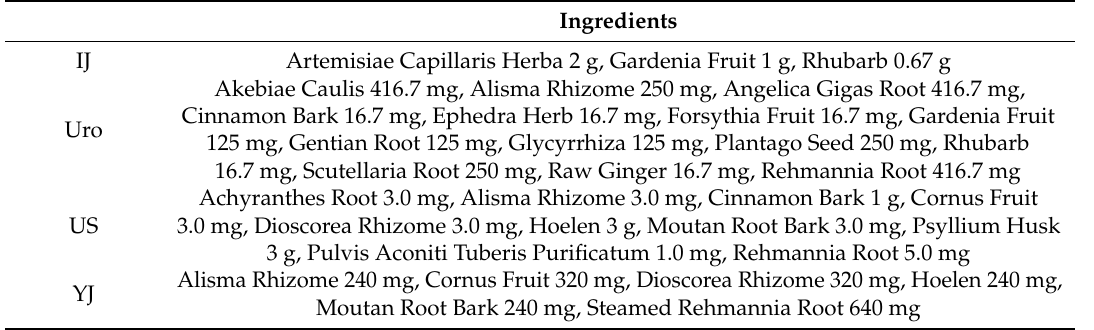
Table 1. Individual herbs composing the polyherbs used in this study.